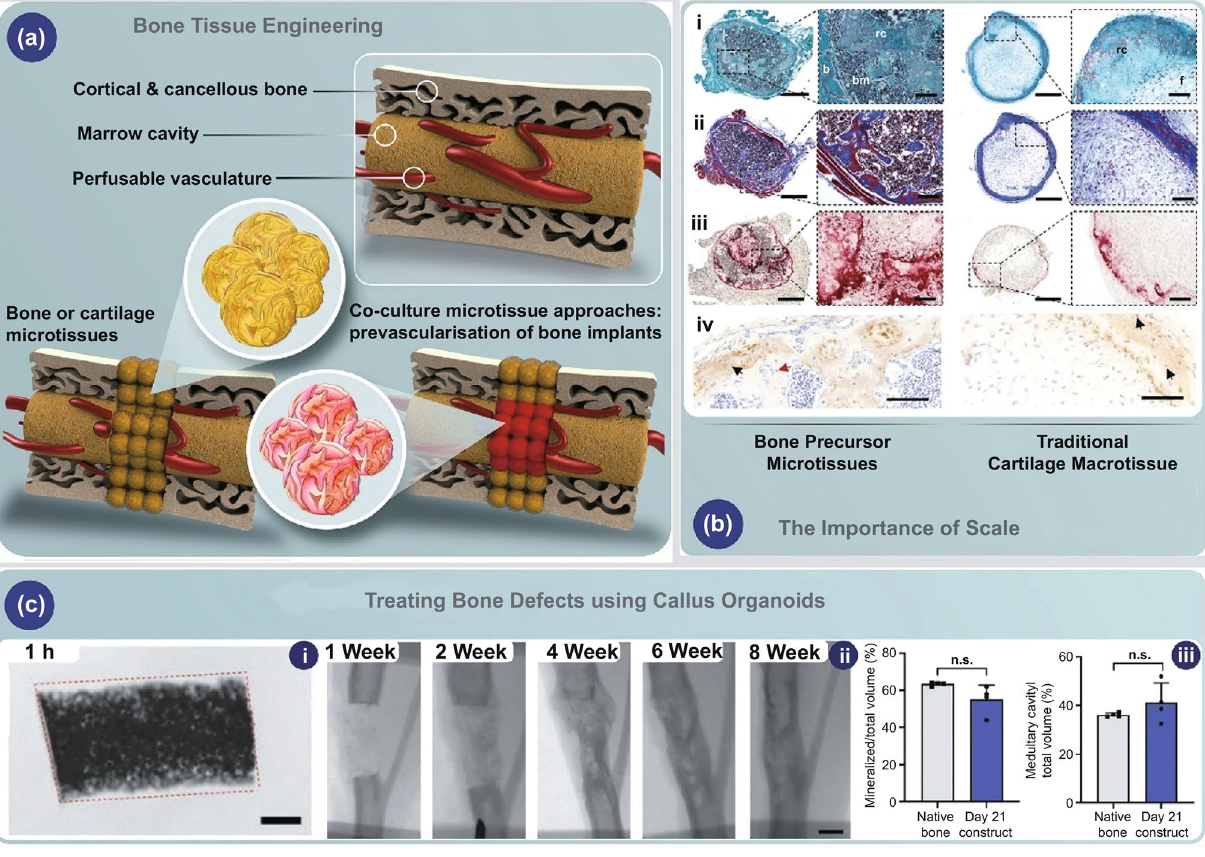
Fig. 1 a Schematic representation of microtissues in bone tissue engineering. b The importance of scale in cartilage precursors for endochon- dral bone tissue engineering. c The same precursor microtissues can be used to heal a murine, critically sized long bone defect. The figure reprinted [18, 19] with permission from Elsevier and